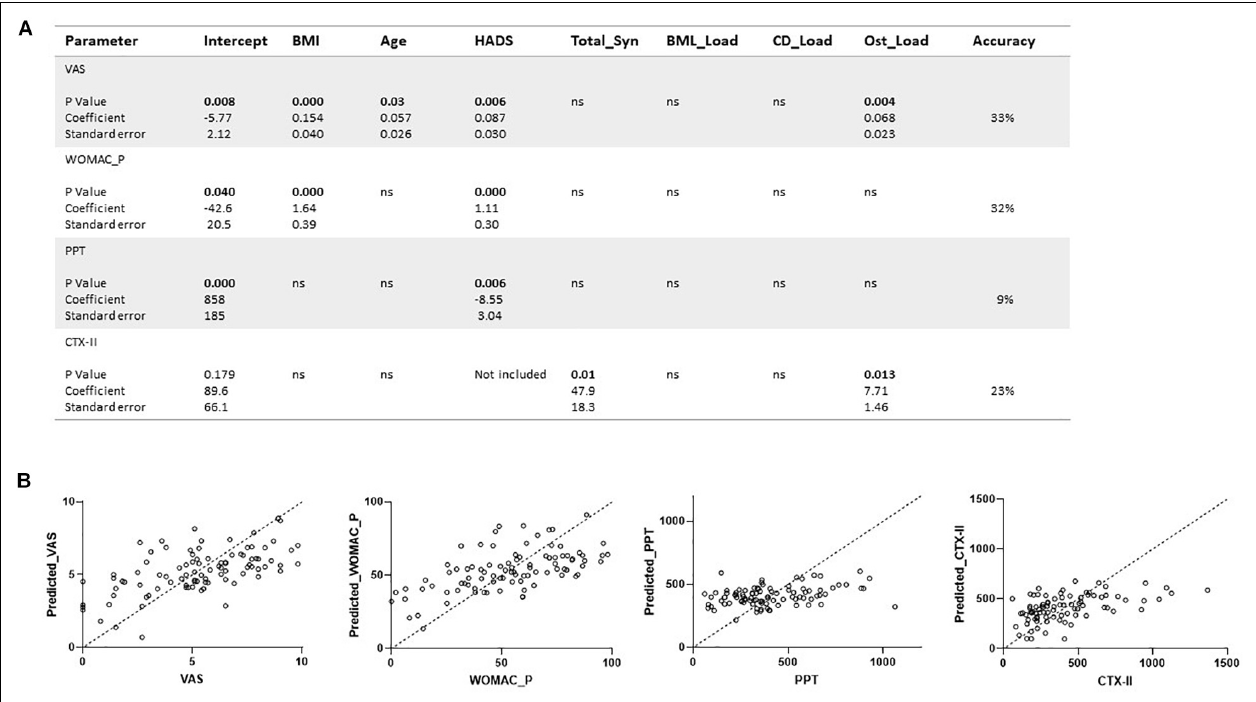
FIGURE 4 | Regression analyses of clinical, biochemical, and structural parameters in knee OA. (A,B) Multivariable regression analyses were conducted for continuous variables including VAS, WOMAC pain, urinary CTX-II, MOAKS-defined damage including bone marrow lesion load (BML_Load), total synovitis (total_Syn), cartilage degradation load (CD_Load), osteophyte load (Ost_Load), pain pressure thresholds (PPT), and Hospital Anxiety and Depression Scale (HADS). Regression analysis is shown for the urinary type II collagen degradation product biomarker (CTX-II) in relation to structural damage by osteophytes and synovitis. Covariates were BMI and age in the analysis. Analyses are presented with p -values, coefficients, and standard error. There were 78 degrees of